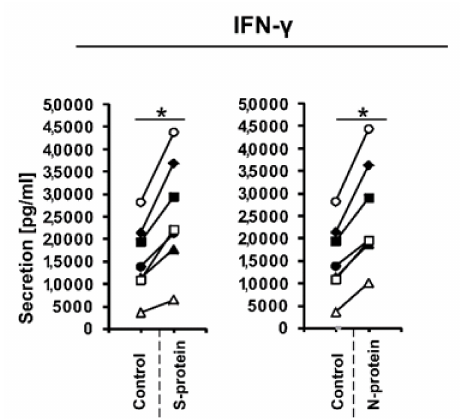
Figure 2. IFN- γ production in cellular supernatants of CD4 + cells isolated from healthy, unexposed donors that were di ff erentiated into Th1 lymphocytes in the presence of 1 µ g / mL SARS-CoV-2 proteins S (spike) and N (nucleocapsid) for 5 days was determined using the human IFN-gamma Quantikine ELISA Kit. Data show individual values for seven independent donors ( n = 7). “Control” denotes cells cultured in the absence of SARS-CoV-2 proteins for 5 days, and “S-protein” or “N-protein” denotes cells cultured in the presence of SARS-CoV-2 protein (S or N, respectively) for 5 days. Control values are the same for both conditions (S and N proteins). Straight lines connecting two points (control and given protein) identify samples from a specific donor. An asterisk indicates a statistically significant di ff erence at p < 0.05. Statistical analysis was performed using Friedman repeated measures ANOVA on ranks followed by Student–Newman–Keuls post hoc test.